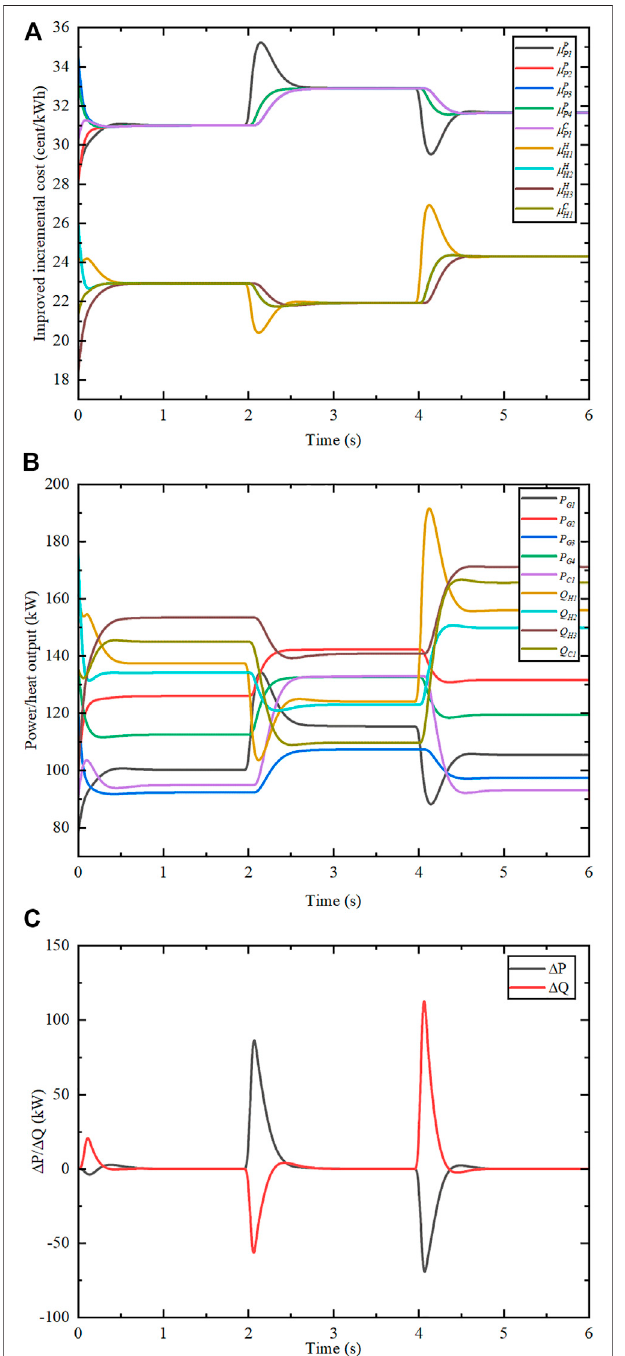
FIGURE 5 | Algorithm results in islanded operation mode. (A) Improved incremental cost. (B) Power output of each unit. (C) Electrical and thermal power mismatch.